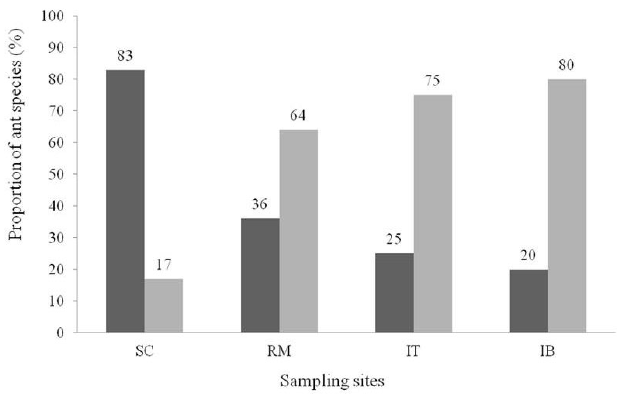
Fig 2. Proportion of ant species exclusive to each site and shared between at least two sites. Sampling site abbreviations: Serra do Cipó (SC), Itaco- lomi State Park (IT), Ibitipoca State Park (IB), and Serra do Rola Moça State Park (RM). Dark bars represent exclusive proportion and light bars correspond to the shared proportion of